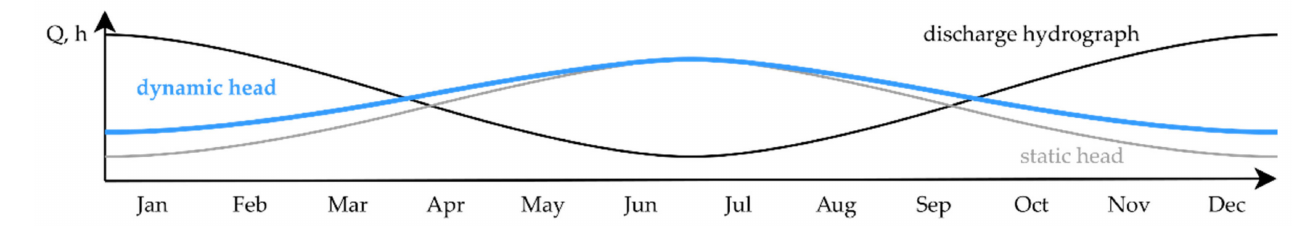
Figure 3. Principle of the dynamic water-level regulation of reservoir levels in a standard year [8].